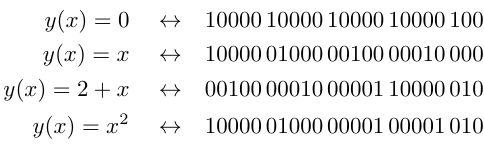
FIG. 1. Examples of the correspondence between functions from Z L to Z L (cid:12) and elementary codewords. We have inserted spaces between the L = 5 blocks of L (cid:12) = 5 qubits. y ( x ) is the index of the 1 in the x th block of qubits.